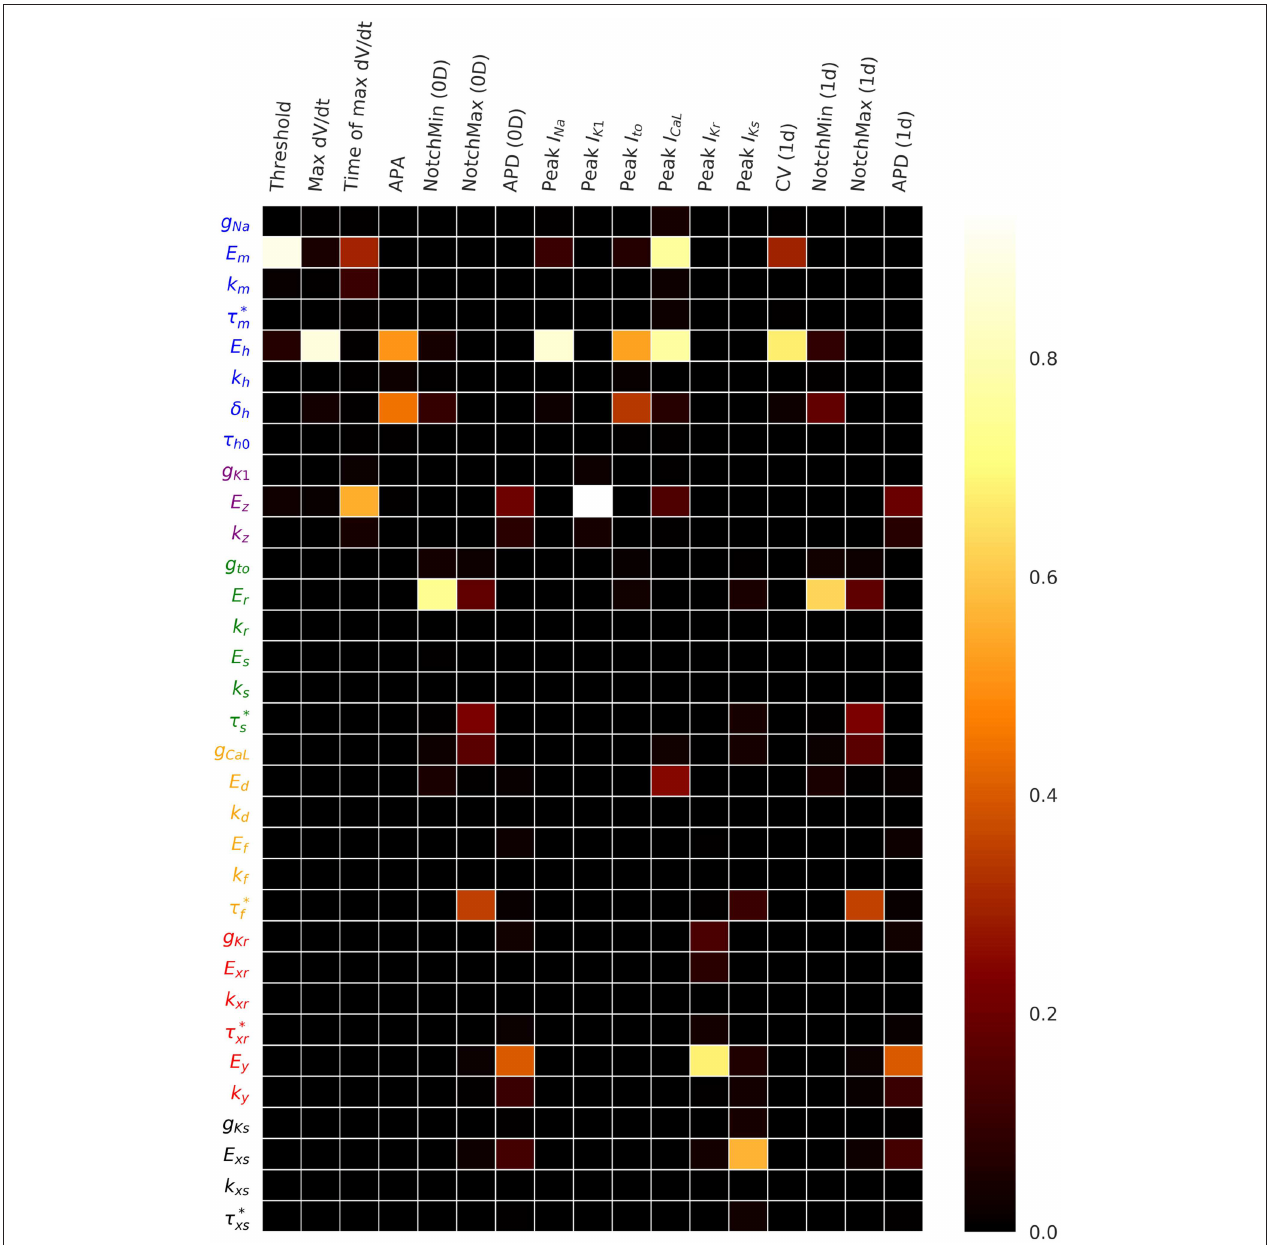
FIGURE 5 | Total Sobol sensitivity indices for a range of QOIs, with ˆ σ = 1 % , which represents a small amount of uncertainty in all cell model parameters. APA is action potential amplitude. APD is action potential duration. CV is conduction